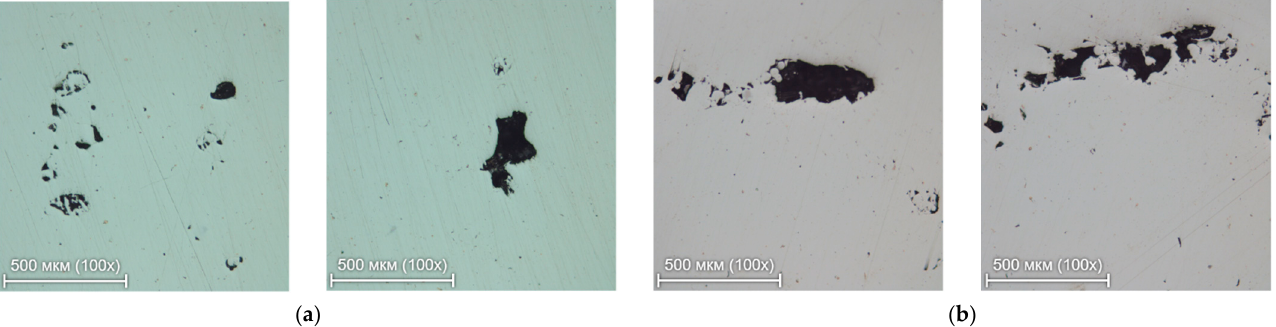
Figure 4. Photographs of the sample 230 W, 1050 mm/s: ( a ) the topmost surface taken from different areas; ( b ) lateral surface taken from different areas.